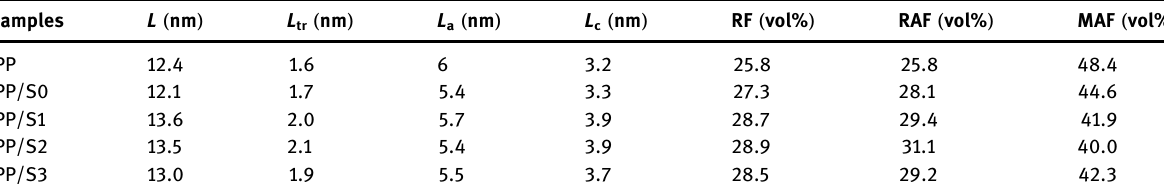
Table 4: Microstructure parameters of iPP composites annealed at 140°C for 1 h